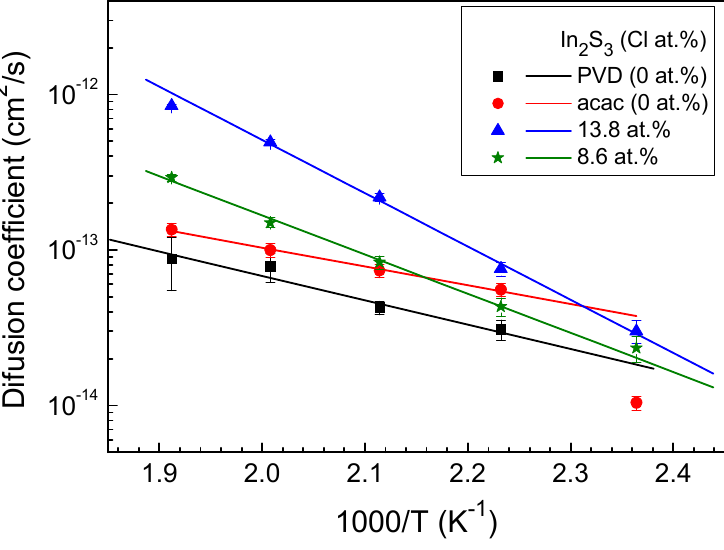
Figure 4. Arrhenius plot of diffusion coefficient against inverse temperature for different In 2 S 3 layers.